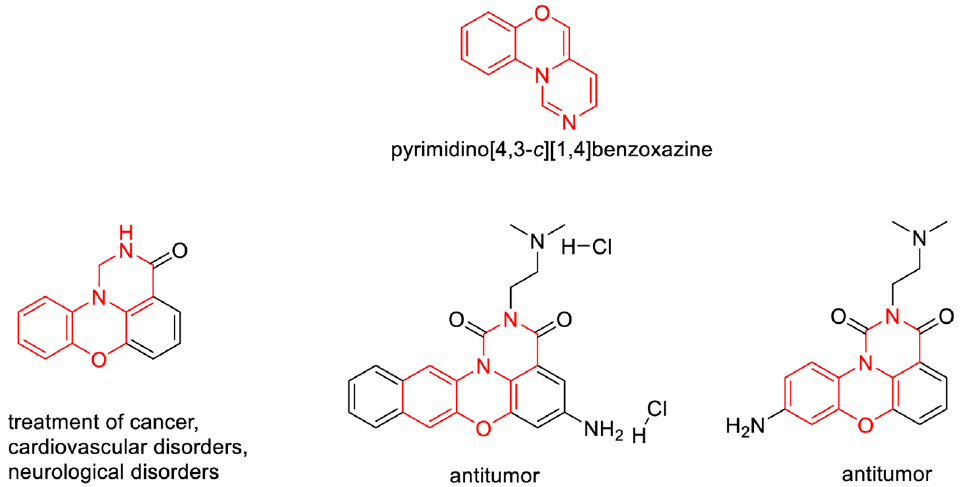
Figure 1. Potential pharmaceutical substances, bearing pyrimidino[4,3- c ][1,4]benzoxazine core. As a continuation of our study on the syntheses of fused heterocycles A or B via reactions of acyl(imidoyl)ketenes C , generated by the thermolysis of [ e ]-fused 1 H -pyrrole- 2,3-diones D [4] (Scheme 1), we synthesized a novel representative of 4-aroyl-1,2-diaryl-1,2- dihydropyrimidino[4,3- c ][1,4]benzoxazine-3,5-diones (type B heterocycles on the Scheme 1) [5]-4-benzoyl-2-(4-bromophenyl)-1-(4-methoxyphenyl)-1,2-dihydropyrimidino[4,3- c ][1,4]benzoxazine-3,5-dione 1 [6], by the reaction of 3-benzoylpyrrolo[2,1- c ][1,4]benzoxazin- 1,2,4-trione 2 with N -(4-bromophenyl)-1-(4-methoxyphenyl)methanimine 3 under thermoly- sis